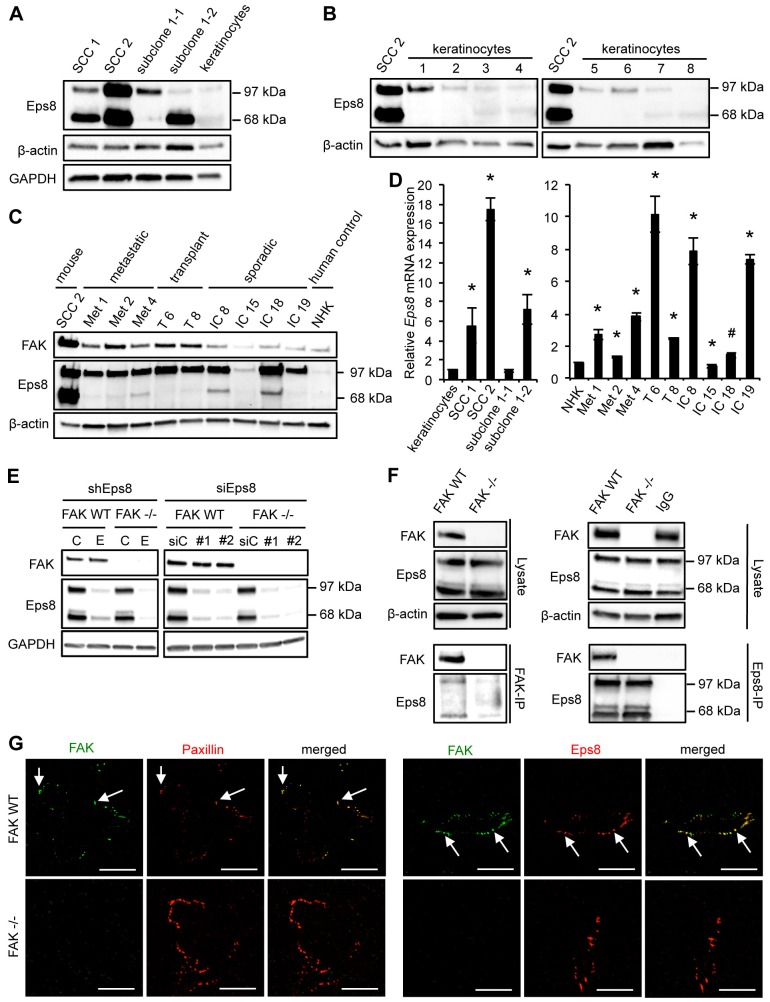
Eps8 expression is upregulated in SCCs and interacts with FAK. (A) Primary keratinocytes were isolated from mouse tails, and Eps8 expression was compared to a number of SCC lines by western blotting using anti-Eps8 antibody. Anti-β-actin (middle panel) and anti-GAPDH (lower panel) antibodies were used as loading controls. (B) Eps8 expression was compared between SCC cell line 2 (SCC 2) and independent keratinocyte cultures by western blotting using anti-Eps8 antibody (upper panel). Anti-β-actin was used as a loading control (lower panel). (C) Eps8 expression was compared between SCC 2, human SCC cell lines and a human NHK control cell line by western blotting using anti-Eps8 antibody (middle panel). Met, metastatic SCC lines; T, SCC lines from patients who had previously received organ transplants; IC, SCC lines from patients with sporadic primary SCC. FAK expression was analyzed employing anti-FAK antibody (upper panel) and anti-β-actin was used as a loading control (lower panel). (D) Relative Eps8 mRNA expression in mouse and human SCC cell lines was analyzed by qRT-PCR using the ΔΔCt method. GAPDH was used as a control for differences in cDNA input. Results are mean±s.d. *P<0.01; #P<0.05 (Student's t-test). (E) FAK expression upon knockdown of endogenous Eps8 by shRNA (shEps8 E lanes; C lanes show control shRNA) or two independent siRNAs (siEps8 #1 and #2; siC, control siRNA) was analyzed using anti-FAK antibody (upper panel). Eps8 knockdown was confirmed by using anti-Eps8 antibody (middle panel) and anti-GAPDH was used as a loading control (lower panel). (F) FAK or Eps8 were immunoprecipitated (IP) from FAK WT and FAK−/− cell lysates using anti-FAK antibody conjugated to agarose (clone 4.47) (left panel) or anti-Eps8 antibody (right panel), followed by western blot analysis with anti-FAK and anti-Eps8 antibodies (lower panels). Eps8 immunoblotting detects both known isoforms with molecular masses of 97 kDa and 68 kDa. Anti-β-actin was used as a loading control. (G) Focal adhesions were isolated from FAK WT and FAK−/− cells using hydrodynamic force. Left panels: focal adhesions (arrows) were stained with anti-FAK and anti-paxillin antibodies. Right panels: focal adhesions (solid arrows) were stained with anti-FAK and anti-Eps8. Scale bars: 20 µm.